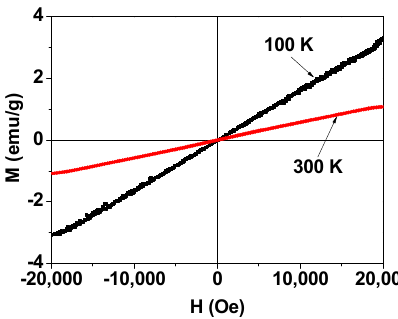
Figure 6. Mass-corrected magnetization versus the applied field (i.e., M ‒ H) curves ( − 2.0 T ≤ H ≤ 2.0 T) at T—100 and 300 K. The M values are the net M values of the MnO nanoparticles without FA-PAA (see text for details). The M ‒ H curve at T = 100 K was slightly noisy owing to the slight temperature instability of the instrument.